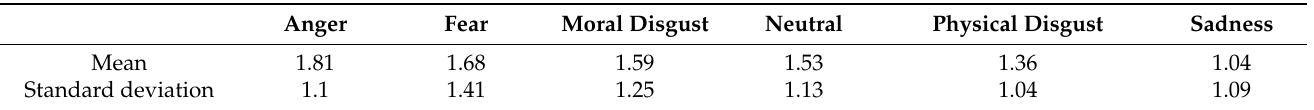
Table 7. Means and standard deviation of individual probability discount rates (log h) across the six experimental conditions (Experiment 2).